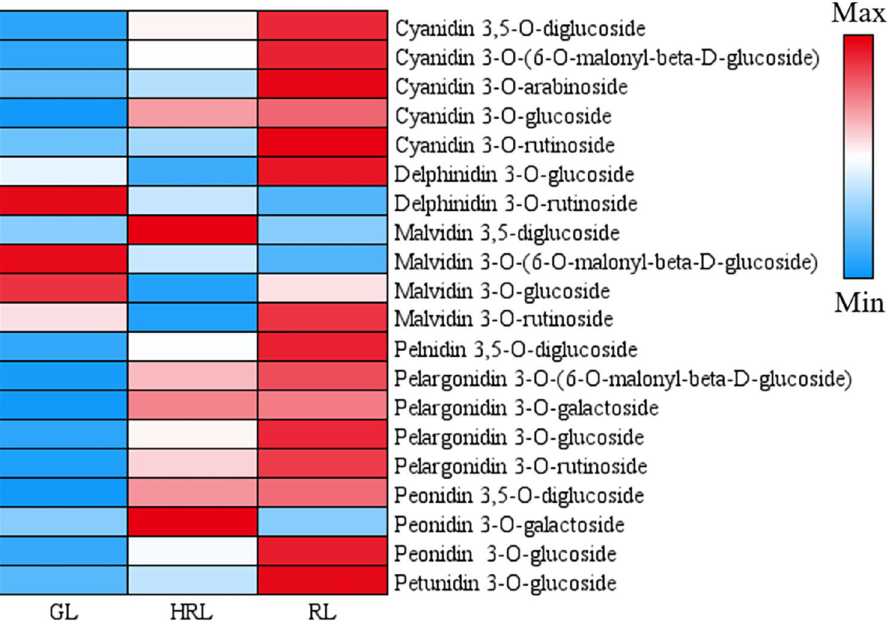
Figure 7. Metabolite accumulation level in anthocyanin synthesis